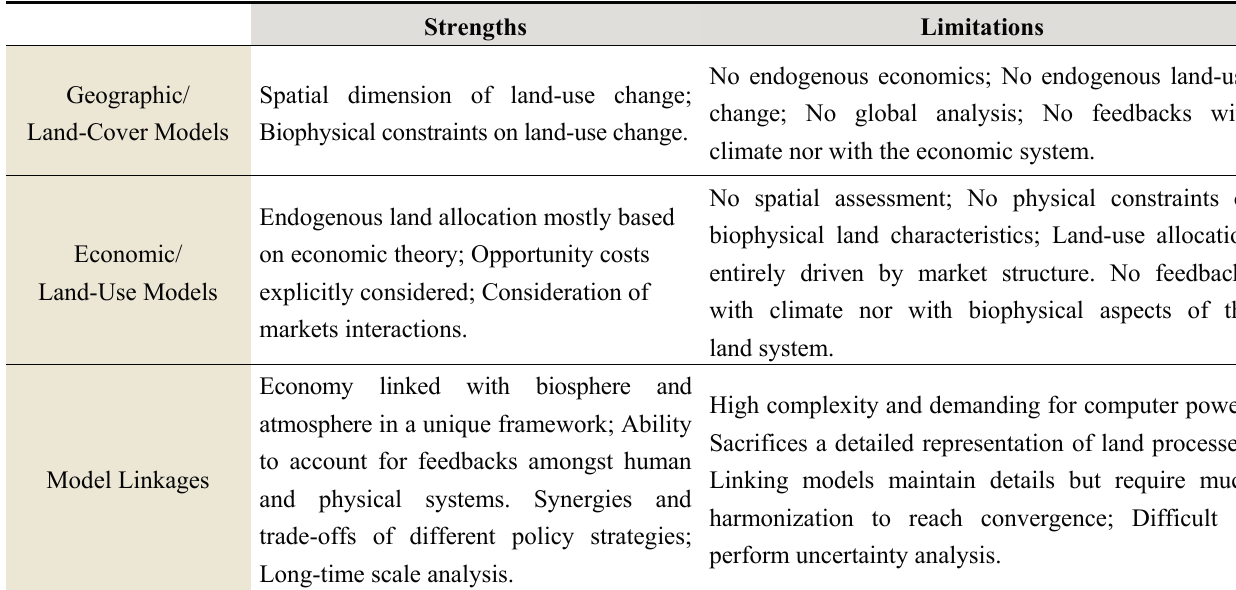
Table 1. Main general characteristics of the modelling categories. Source: Own Elaboration. Strengths